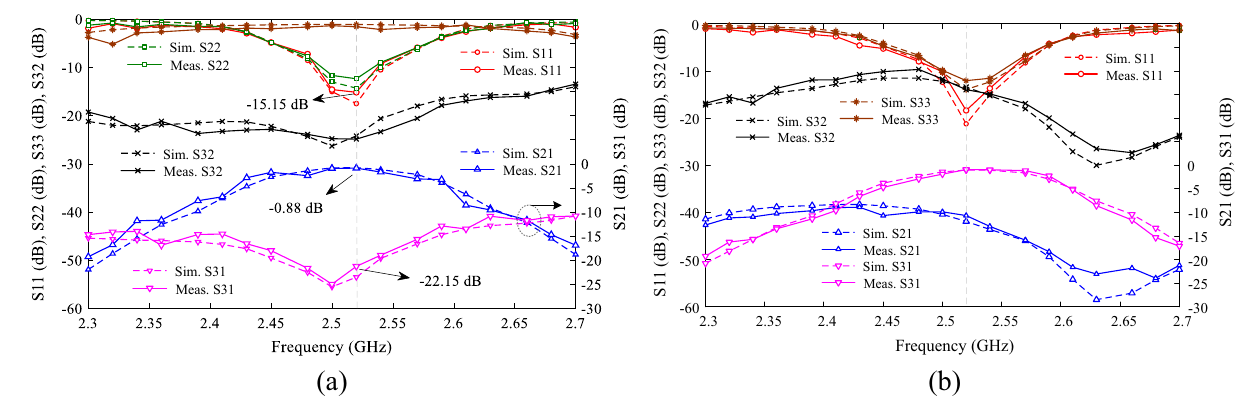
Figure 12. Measurement and simulation results of second design TWPD, ( a ) at V1 = 4 and V2 = 1.7, and ( b ) at V1 = 4 and V2 =